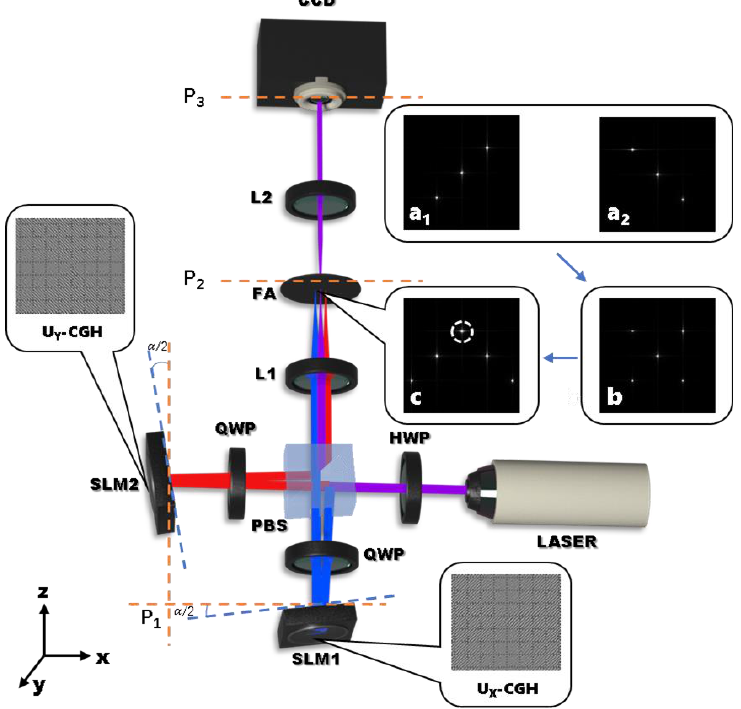
Figure 1. Architecture of the experiment setup. LASER: He-Ne laser; HWP: half-wave plate; PBS: polarizing beam splitting prism; QWP: quarter-wave plate; SLM1-SLM2: reflective liquid crystal spatial light modulators; L1-L2: the Fourier Lens; FA: the filtered aperture; CCD: charge-coupled device; a 1 is the spectral distribution of x-polarized light on the spectral plane of lens 1; a 2 is the spectral distribution of y-polarized light on the spectral plane of lens 1; b is the spectral surface when the liquid crystal spatial light modulator is not tilted; c is the spectral surface after the liquid crystal spatial light modulator is tilted.